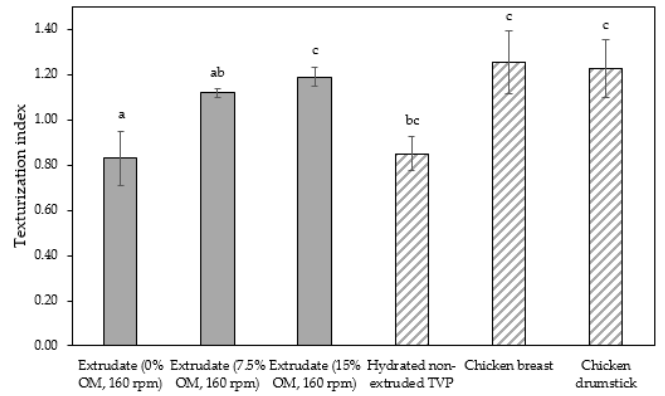
Figure 3. Texturization index of extrudates containing 0%, 7.5%, and 15% oyster mushroom compared with hydrated textured vegetable protein (TVP) and chicken meat (breast and drumstick). Note: Different superscript indicates significant difference at p ≤ 0.05.